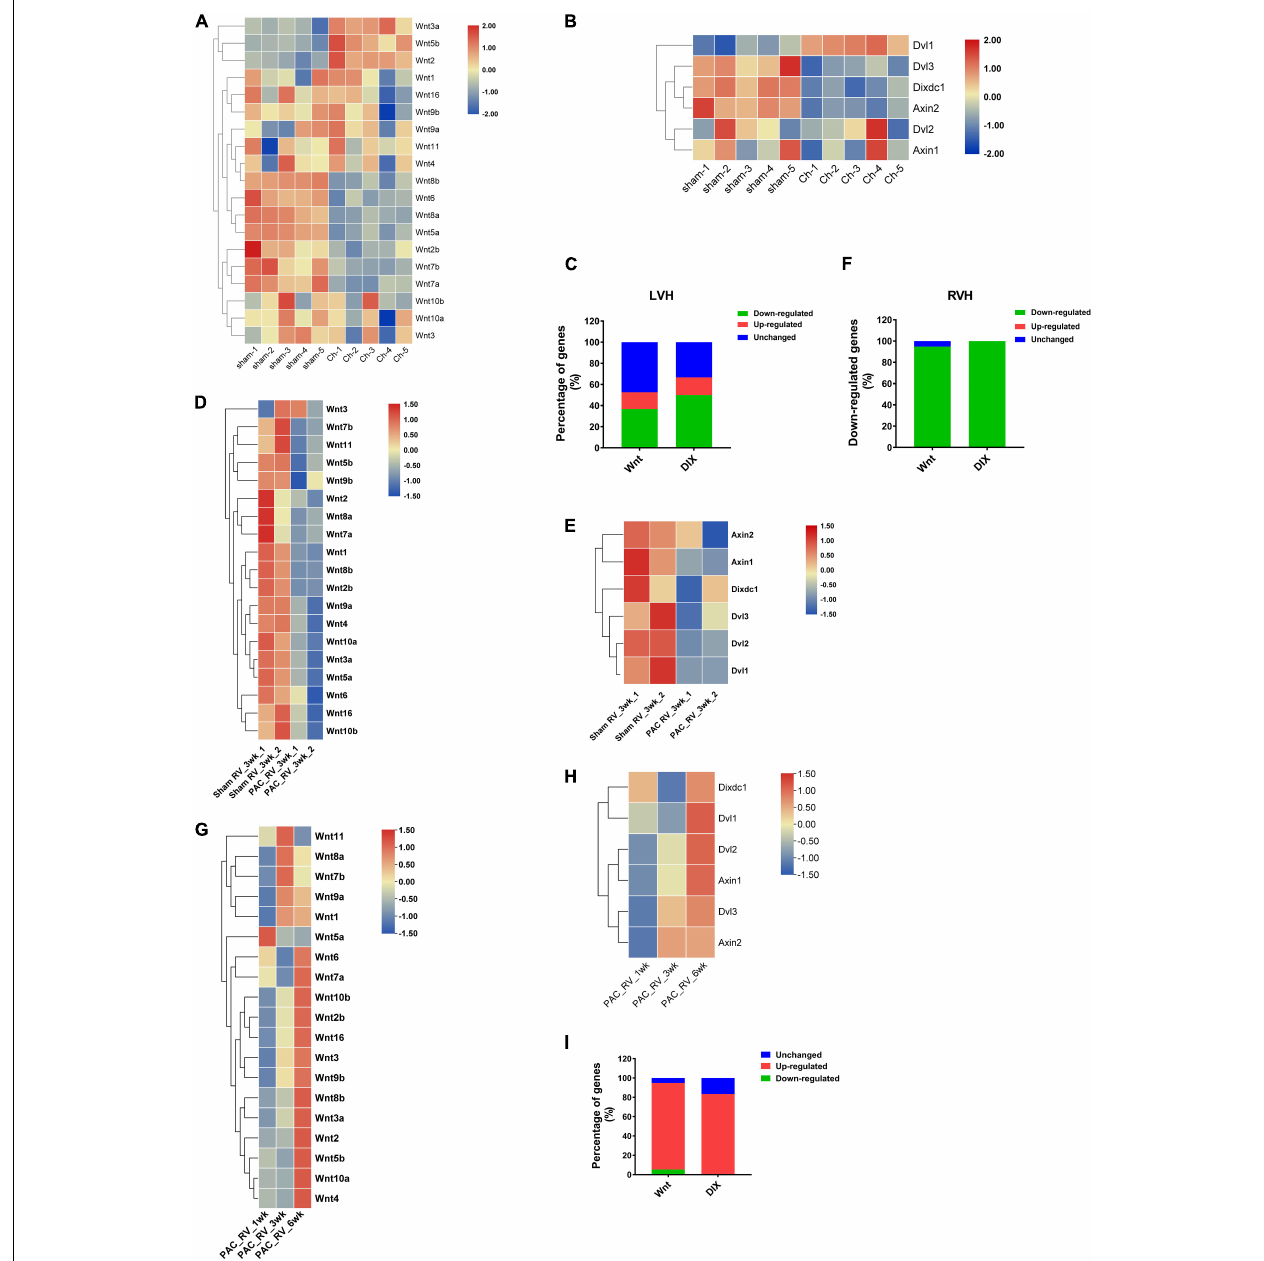
FIGURE 7 | The expression patterns of mouse Wnt and DIX genes in left and right ventricle hypertrophy. Expression patterns of Wnt genes (A) and DIX genes (B) in the left ventricle of the mouse heart. Sham indicates sham operations, Ch indicates TAC operations induced chronic hypertrophy. The color scale bars represent the differential expression levels of each gene. (C) The ratio of downregulated Wnt and DIX genes in the left ventricle of mice after TAC or Sham operations. (D) Expression patterns of Wnt genes and DIX genes (E) in the right ventricle of the mice heart. Sham indicates sham operations, PAC indicates pulmonary artery clipping operations. 3wk means 3 weeks after operations. (F) The expression change of Wnt and DIX genes in the right ventricle of mice when 3 weeks after PAC operations. (G) Expression patterns of Wnt genes and DIX genes (H) in the right ventricle of the mice heart when 1 week, 3 weeks and 6 weeks after PAC operations. (I) The expression change of Wnt and DIX genes in the right ventricle of mice when 1, 3, and 6 weeks after PAC operations. All heatmaps were generated by using the pheatmap package in R software (version 4.0). The color scale bars represent the differential expression levels of each gene.